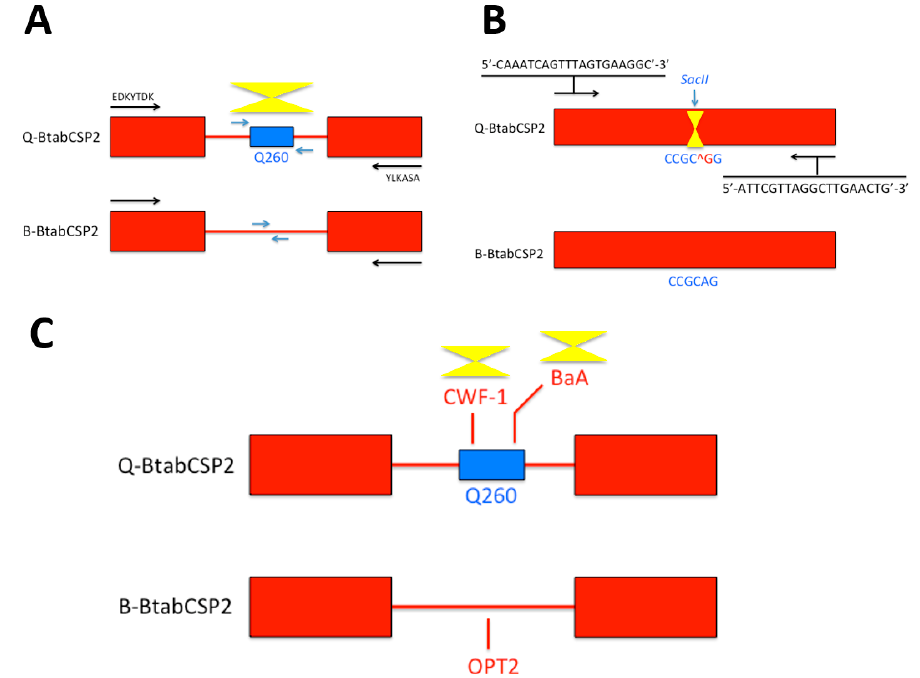
Figure 1. Genotyping B and Q Bemisia CSPs based on Q260, SacII sites and SCAR markers. ( A )